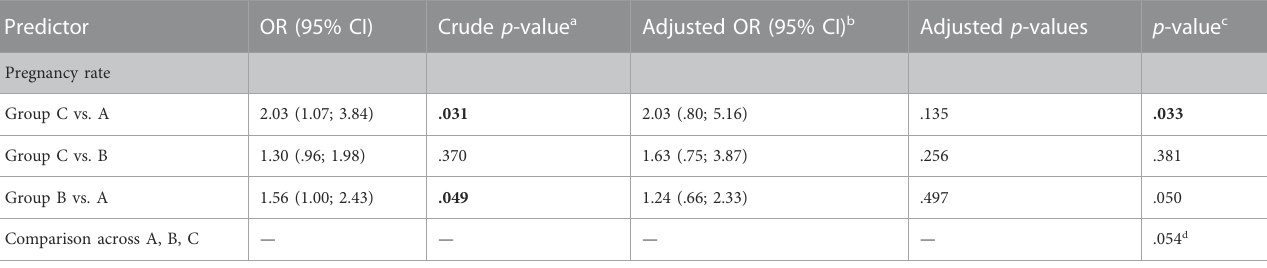
TABLE 9 Comparison of the success rates across temporal groups. Predictor